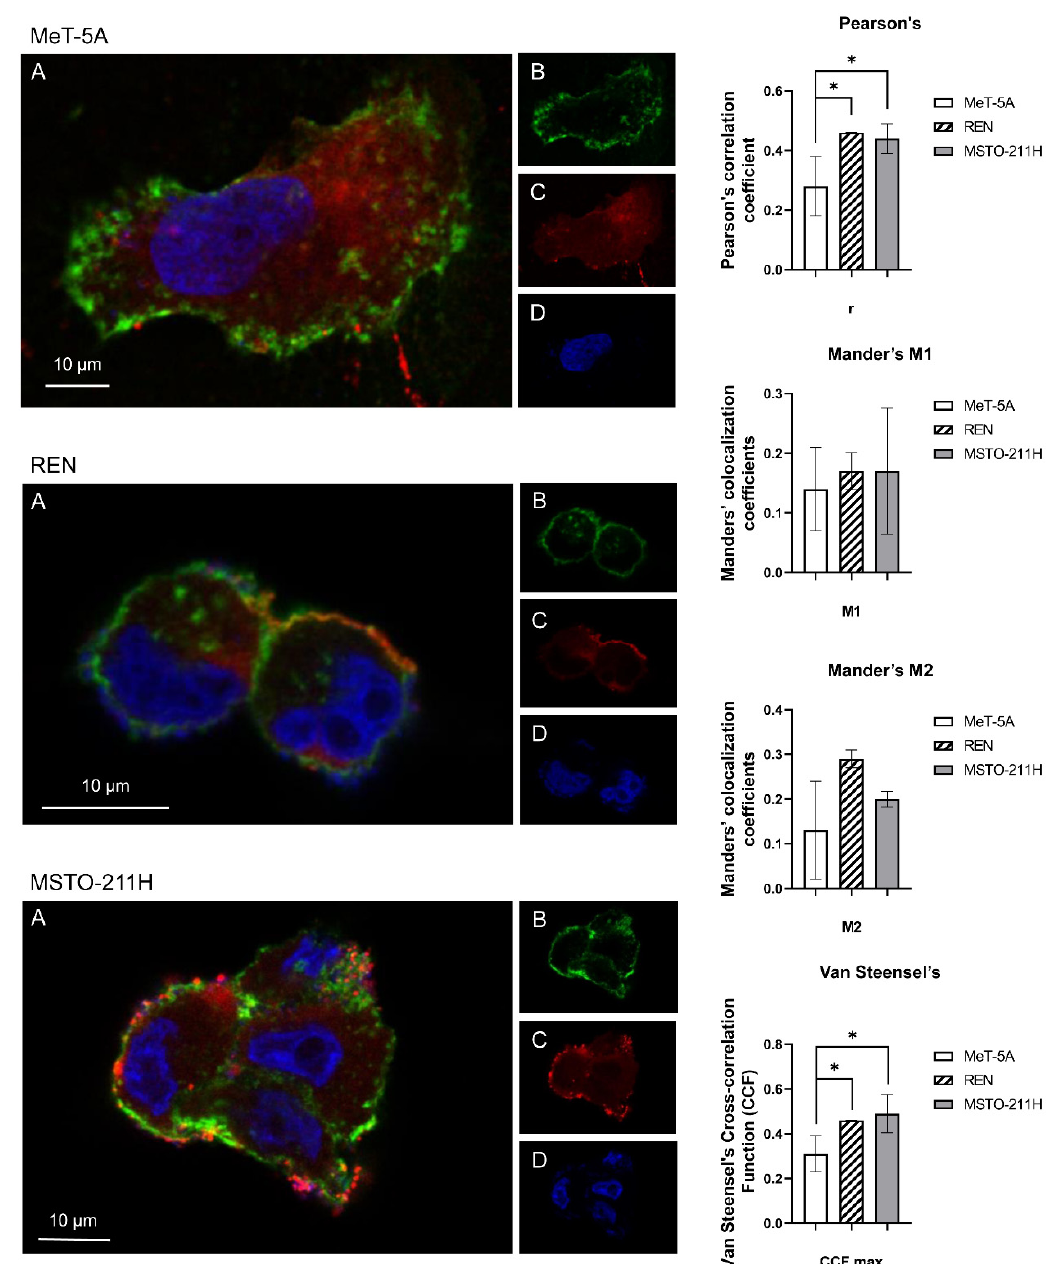
Figure 4. Representative images of confocal laser scanning microscopy and 3D colocalization analysis of AQP6 ( A – D ) with concanavalin A (ConA) in MeT-5A, REN, and MSTO-211H cell lines. Green labeling indicates the presence of ConA ( B ), red labeling indicates the expression of AQP6 ( C ), while DAPI (blue, D ) indicates counterstained nuclei. Yellow labelling shows the colocalization signal of AQP with ConA ( A ). Scale bar: 10 µm (right panel). Statistical analysis of Pearson’s correlation coefficient r, Manders’ colocalization coefficient (M1 and M2), and Van Steensel’s maxima cross-correlation function (CCF) were obtained from 4 different double immunofluorescence experiments with anti-AQP6 antibody and anti-AQP6 antibodies. Coefficients were determined by 3D analysis of at least 20 cells for each cell line (8–15 z-stack for image) using the JACoP plugin of Fiji. The columns represent the mean ± SD of the coefficient values; *, p < 0.05 (ANOVA, followed by Newman–Keuls’s Q test).